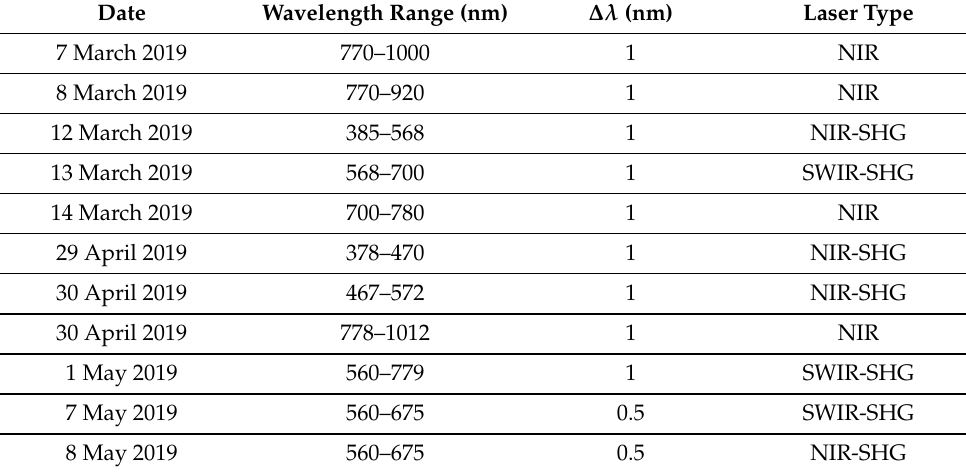
Table 2. SOLARIS GLAMR RadCal